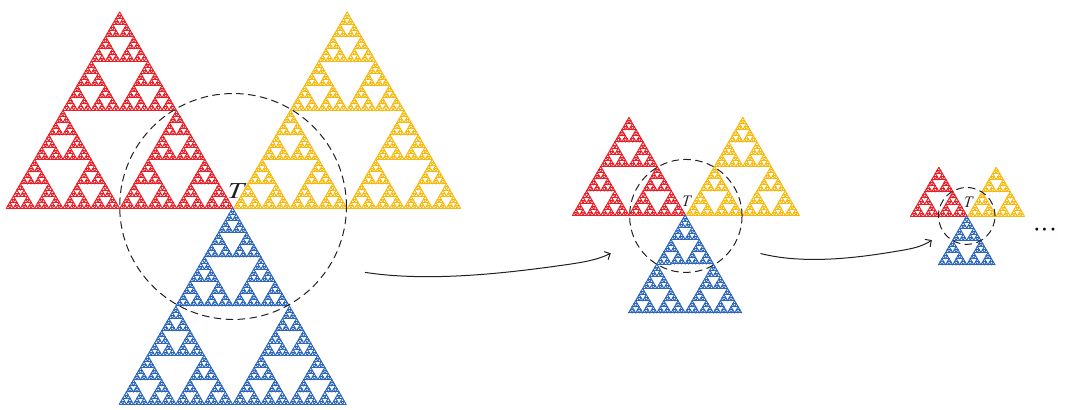
Figure 3. The scaled copies of the classical Sierpinski propeller for m =